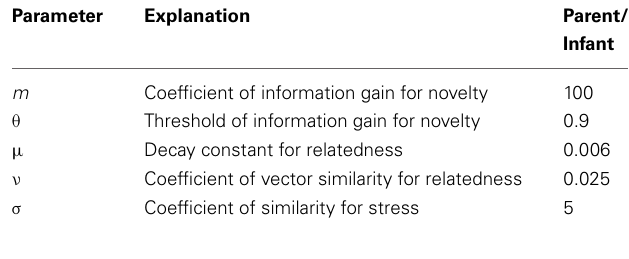
Table 1 | Parameters of emotional